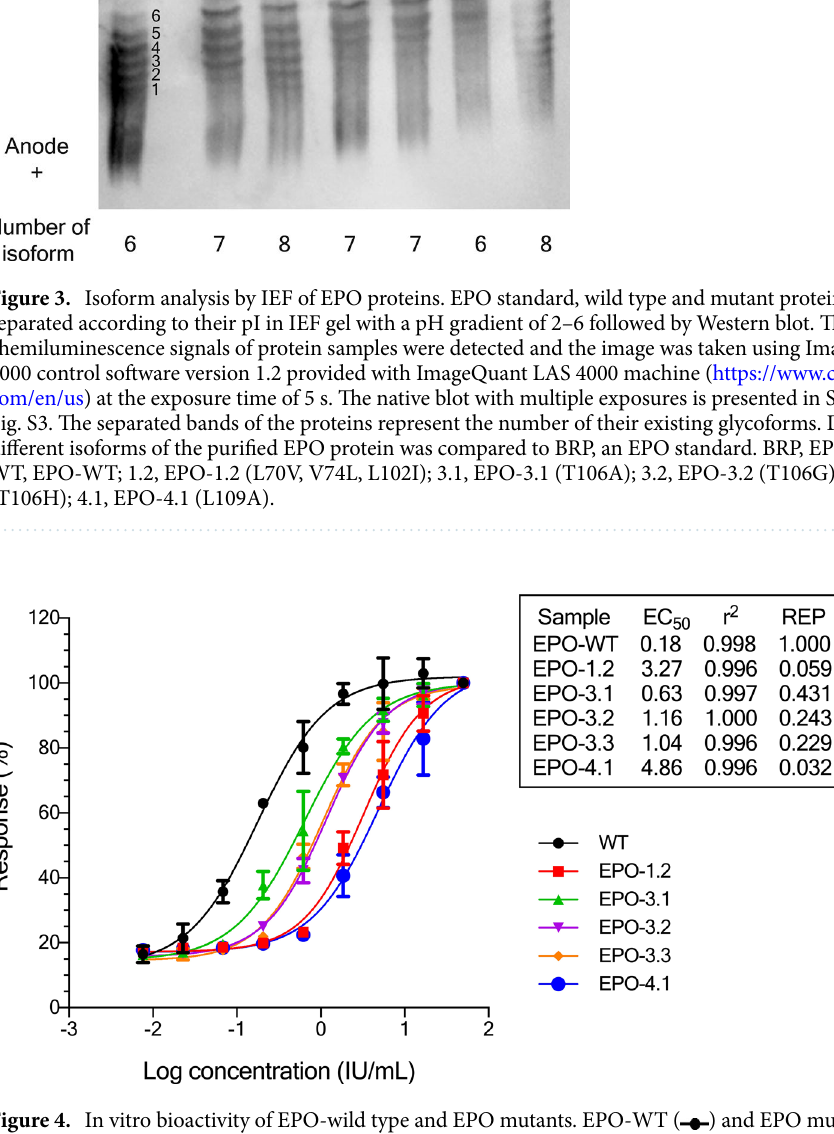
four women (36%) and seven men (64%). All HLA-DRB1*09 negative and positive volunteers were randomly selected for immunogenicity test and were confirmed to be negative for common infectious diseases including hepatitis B, hepatitis C, syphilis, and HIV. To test whether the engineered EPO proteins with disrupted HLA- DRB1*09 binding affinity were less immunogenic, PBMCs from 3 HLA-DRB1*09 negative volunteers and 3 HLA-DRB1*09 positive volunteers were isolated. The high resolution of HLA-DRB1 types of these 6 volunteers are presented in Supplementary Table S1. Precursor DCs were separated from other immune cells by adherence to plastic whereas non-adherent cells were used as a source of CD4 + T cells. Maturation of precursor DCs to immature DCs by determination of HLA-DR expression was monitored by flow cytometry using FITC-conju- gated anti-human HLA-DR. Percentage of immature DC maturation of both groups ranged from 50.7 to 80.4